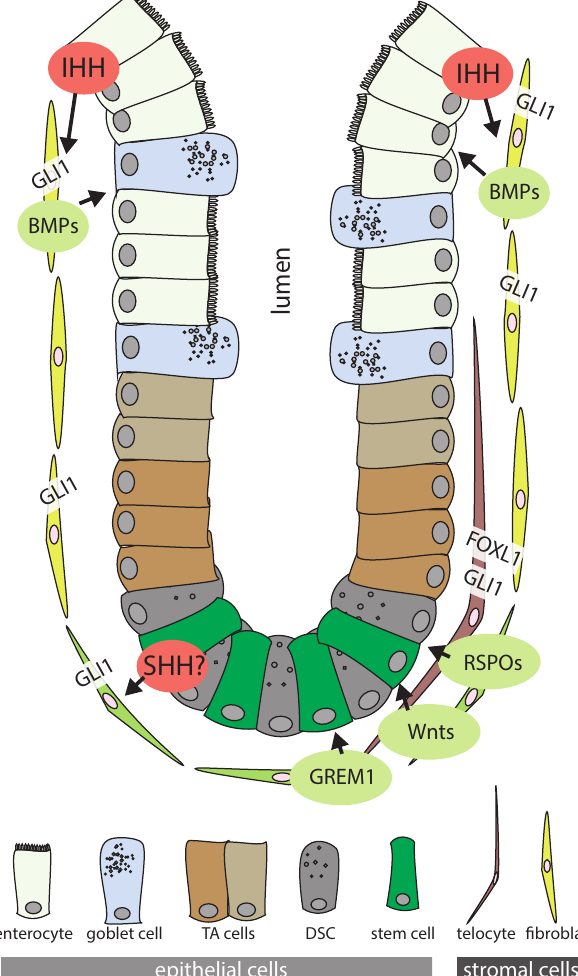
Figure 2. The cell types and signaling molecules involved in colonic Hedgehog (Hh) signaling. Cells with active Hh signaling are located in the stroma around the colonic crypt and comprise different types of fibroblast-like cells, as well as telocytes. In the epithelial layer, stem cells (green) are located at the base of the crypt, adjacent to deep crypt secretory cells (DSCs) [68]. Epithelial cells follow differentiation trajectories via transit-amplifying (TA) cells that end in enterocytes or goblet cells. For the sake of clarity, other cell types, such as tuft cells or enteroendocrine cells are not shown. Enterocytes towards the luminal side secrete Hh ligand, largely IHH. Stromal cells reacting to the Hh ligand express GLI1 and respond with secreting differentiation factors such as BMP ligands, mainly at the luminal part and close to differentiated epithelial cells. In the crypt region, stromal cells provide both Wnt ligands and BMP inhibitors, such as GREM1, that maintain the epithelial stem cell state. Telocytes can compartmentalize the secretion of both differentiation factors and stem cell factors. Transcription factors (GLI1, FOXL1) expressed in stromal cells are shown in the rectangles. Secreted molecules in are shown in the circles. The legend of cell types is shown at the bottom of the